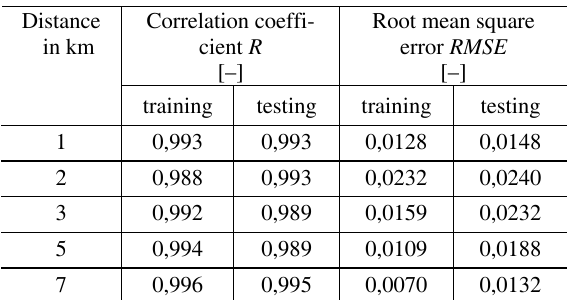
Table 3. Correlation coefficient and RMSE values for BPNN- CGB for identifying productivity W (N),S at specified hauling distances Correlation